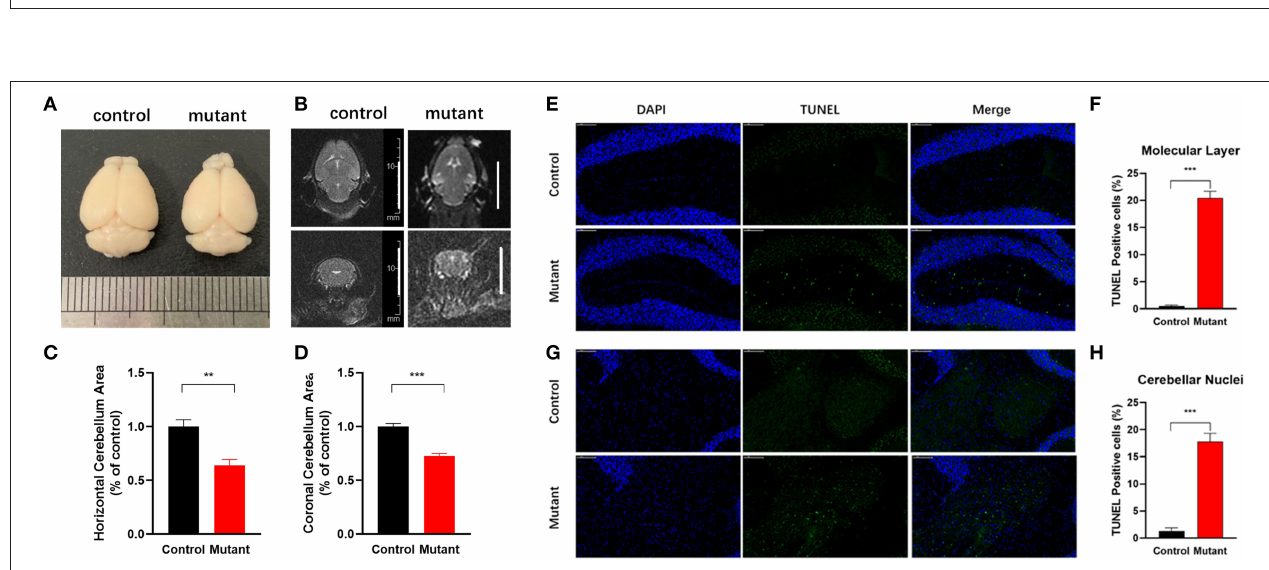
FIGURE 2 | Reduced cerebellar volume and increased apoptosis in Scn8a PC mutant cerebellum. (A) Representative whole-mount images of control and PC Scn8a mutant brains at 9 months of age. The mutant cerebellum appears smaller than control. (B) Magnetic resonance imaging T2 axial and coronal images of the brain showing cerebellar volume loss in the mutant mice at 9–10 months of age (scale bar 10mm). (C,D) Measurement of the cerebellar area of Scn8a mutant and control mice using T2-weighted 3.0T MR imaging. Quantitative analysis revealed a significant reduction in cerebellar area in mutant animals in both axial (C) and coronal area (D) (Mean ± SEM; n = 5 per group; ** P < 0.01, *** P < 0.001, Student’s unpaired t -test). (E,G) Sections of cerebellum of control and PC Scn8a mutant mice at 9–10 months of age labeled with TUNEL showing apoptosis in the molecular cell layer and cerebellar nuclei (Scale bar: 100 µ m). (F,H) Percentage of TUNEL-positive cells per unit area of cerebellar molecular layer and deep cerebellar nuclei in the PC Scn8a mice compared with controls ( n = 4 for each group, *** P < 0.001, Student’s unpaired t -test).